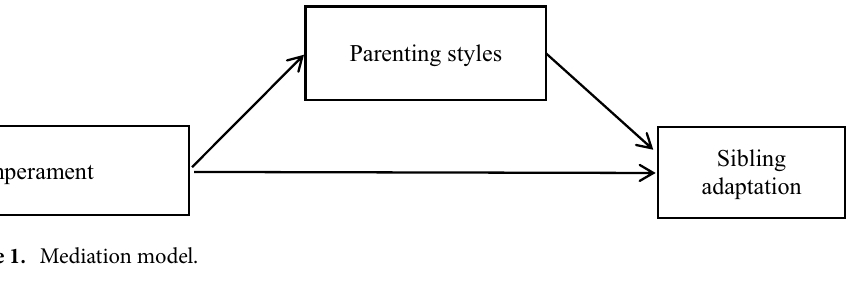
Figure 1. Mediation